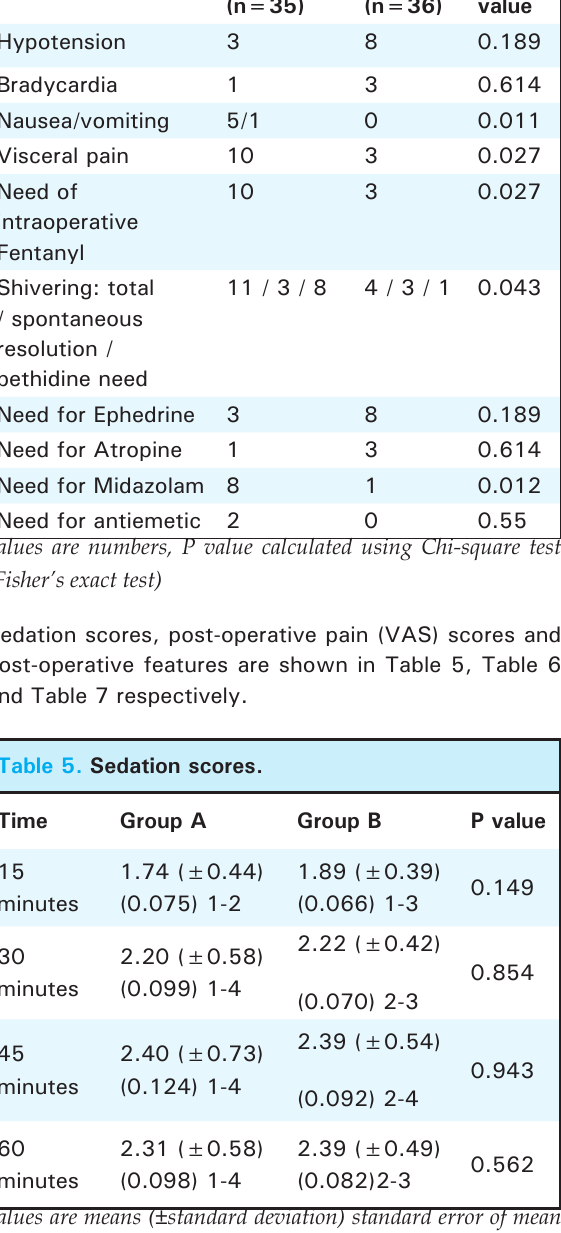
Table 6. Post-operative pain (VAS) scores.